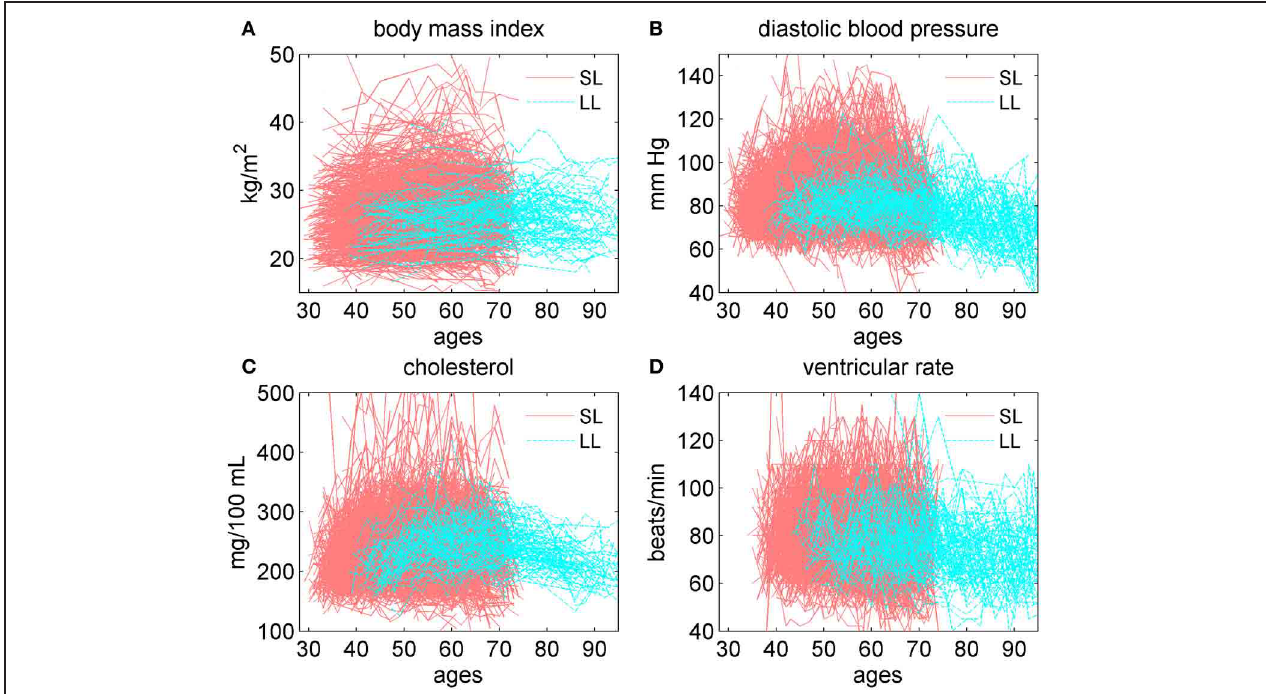
FIGURE 4 | Individual trajectories of four physiological variables in groups of short-lived individuals (“SL,” those dying at ages 75 or earlier; censored individuals are excluded from this group) and 100 longest lived